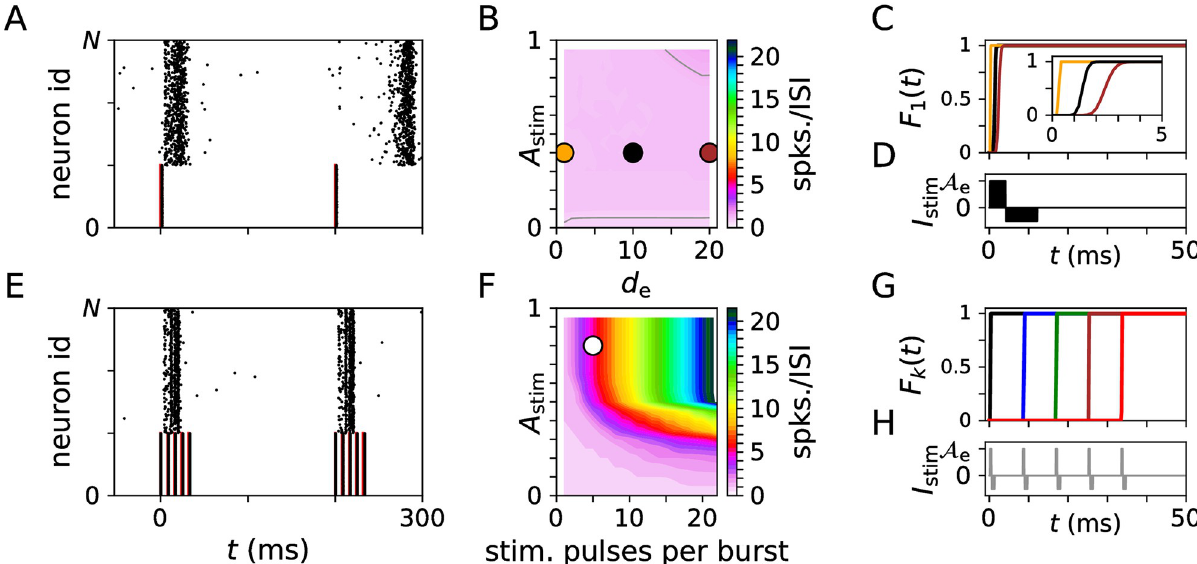
Fig 2. Statistics of LIF neurons’ spiking responses to periodic delivery of single-pulse (top) and burst stimuli (bottom). A: Raster plot of spiking activity of a network of 10 3 LIF neurons during periodic single-pulse stimulation (red bars) of 333 neurons. B: Mean number of spikes per ISI and neuron as function of the dimensionless stimulation amplitude, A stim , and pulse width, d e (Methods). Gray contour lines correspond to 0.75 and 1.25 spikes per ISI and neuron (from bottom to top). C: Cumulative distribution function of the timing of the first spike of LIF neurons after stimulus R t delivery F ð t Þ ¼ du L 1 ð u Þ (Methods) for the stimulus parameters marked orange, black, and brown, respectively, in panel B. The inset zooms into 1 0 the first 5 ms. The stimulation current, I stim , corresponding to d e = 10 is shown in panel D. E: Same as A but for burst stimuli with five pulses per burst and an intraburst frequency of 120 Hz. F: Mean number of spikes per ISI and neuron as function of the number of stimulus pulses per burst and the stimulation amplitude. G: Cumulative distribution function of the timing of the k th spike per ISI F white in panel F. Color code: F 1 ( t ) (black), F 2 ( t ) (blue), F 3 ( t ) (green), F 4 ( t ) (brown), and F 5 ( t ) (red). H: Corresponding stimulation current, I stim . Parameters: f = 5 Hz (all); A stim = 0.4, and d e = 10 (A,C,D) and d e = 1 (C, orange) and d e = 20 (C, brown); and A stim = 0.8, d e = 1, and 120 Hz intraburst frequency (E, F, G,